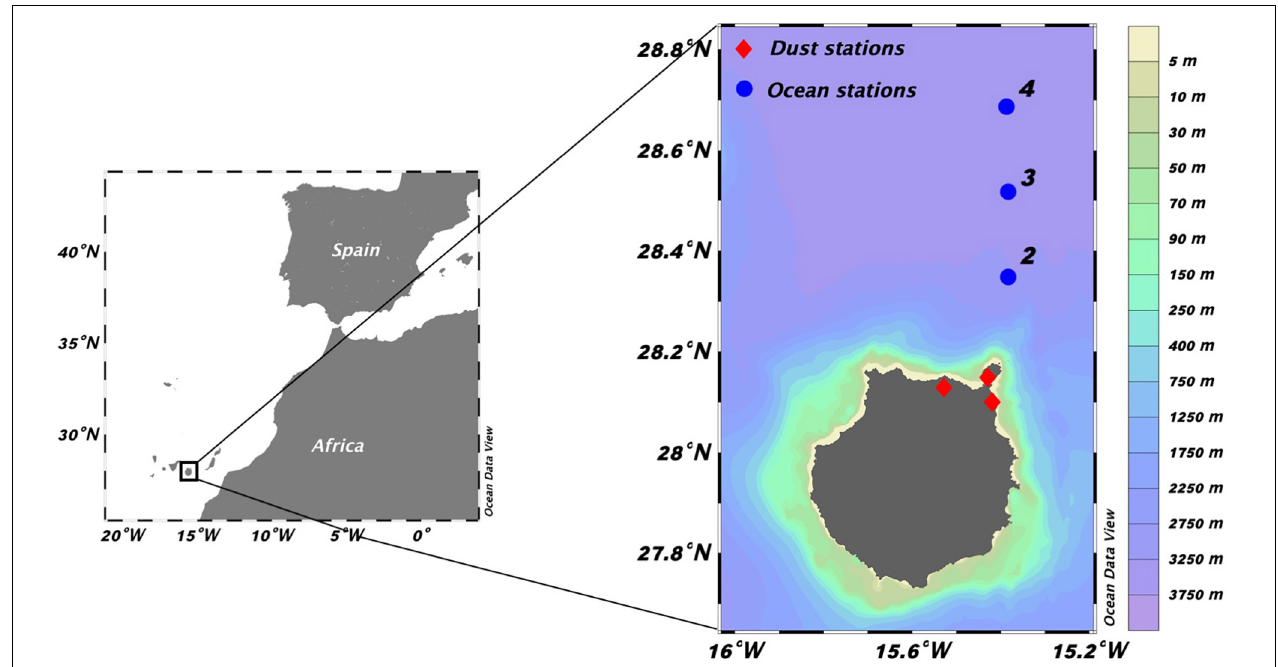
FIGURE 1 | Location of the oceanographic stations ( • ) and the dust stations ( (cid:7) ) at the North of Gran Canaria (Canary Islands).